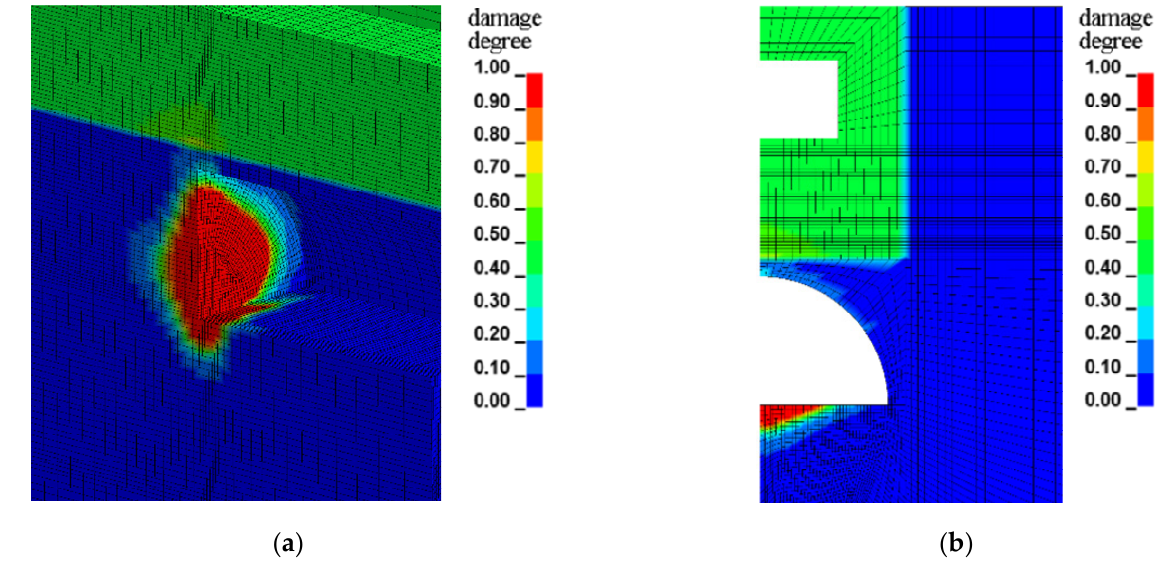
Figure 13. Blasting damage diagram of surrounding rock ( d = 4 m). ( a ) three-dimensional blasting damage diagram. ( b ) cross-section blasting damage diagram.